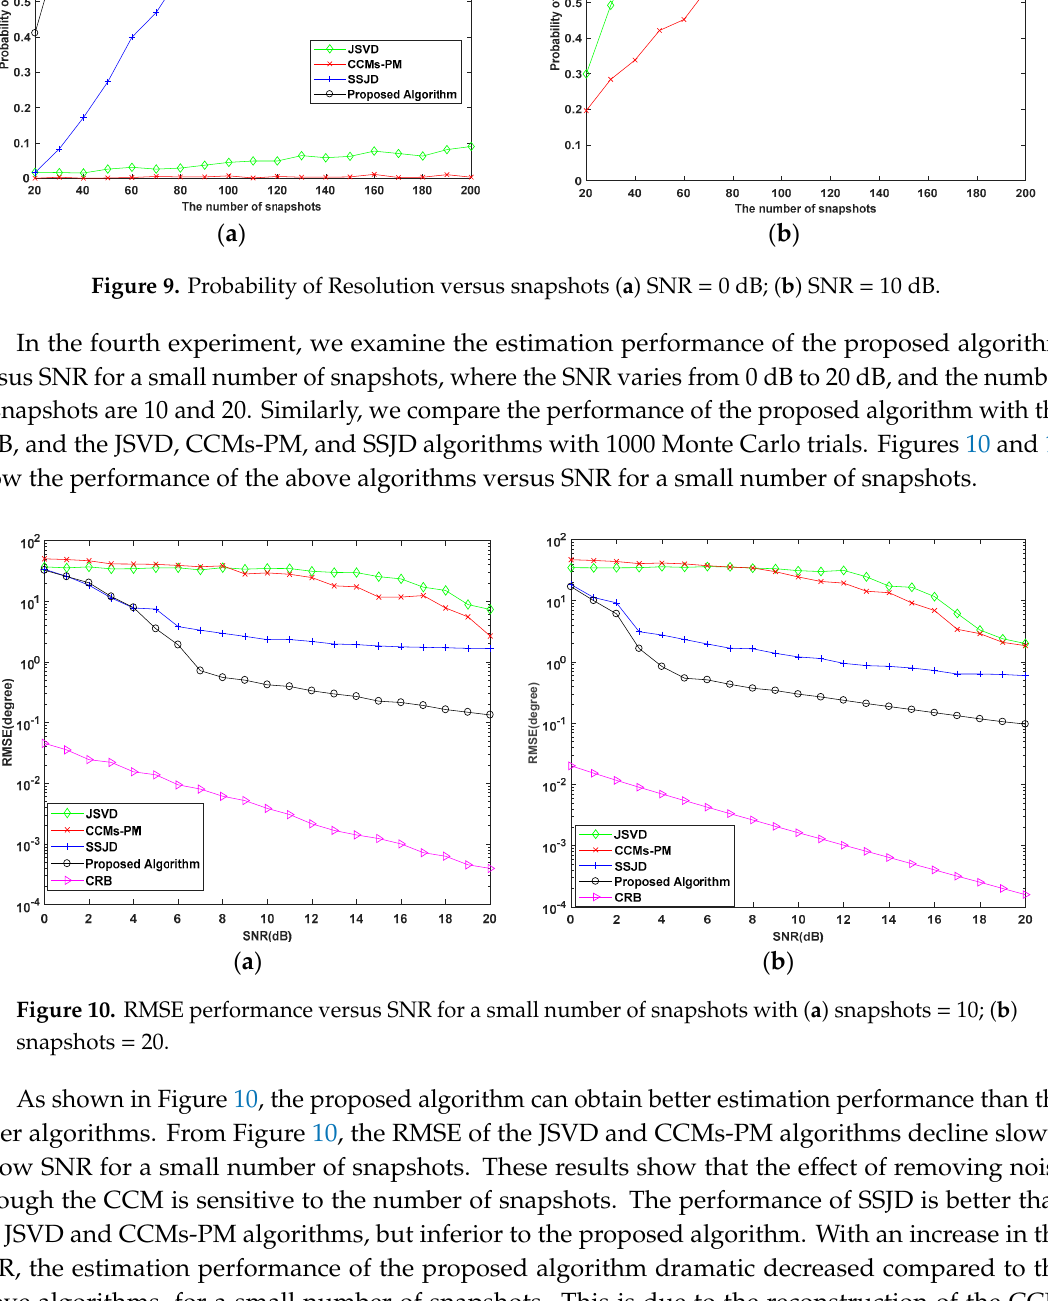
Figure 8. RMSE performance versus the number of snapshots for ( a ) SNR = 0 dB; ( b ) SNR = 10 dB.